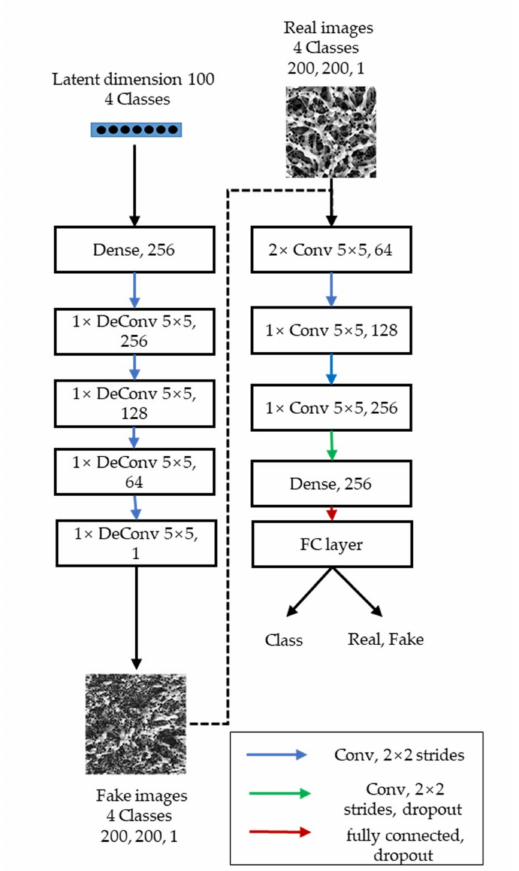
Figure 3. Auxiliary classifier generative adversarial networks (ACGAN) model structure